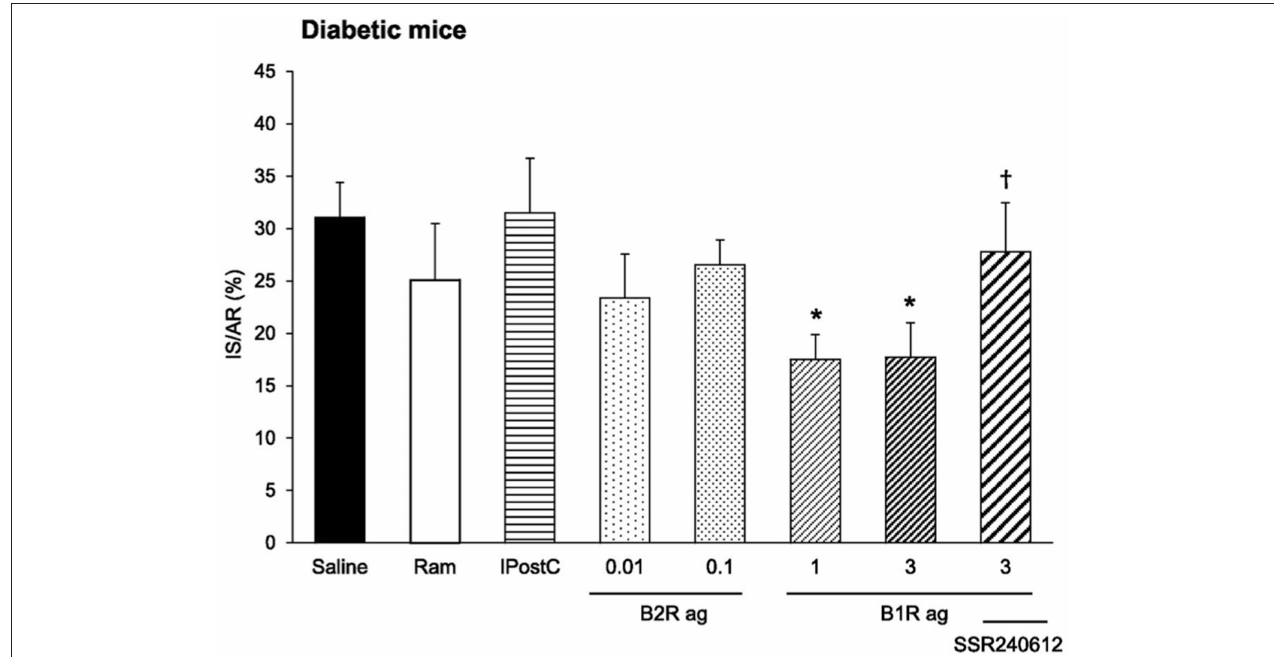
FIGURE 7 | Cardioprotective effect of a pharmacological kinin B1 receptor agonist in cardiac ischemia-reperfusion in diabetic mice. IS/AR, infarct size relative to area at risk; B1R ag, kinin B1 receptor agonist; B2R ag, kinin B2 receptor agonist; Ram, ramiprilat; IpostC, ischemic post-conditioning; SSR240612, kinin B1 receptor antagonist * p < 005 compared to saline, † p < 0.05 compared to B1R ag. Note resistance of the diabetic heart to cardioprotective treatments otherwise efficient in non-diabetic mice (Ram, B2R ag and IpostC). Reproduced from Potier et al.